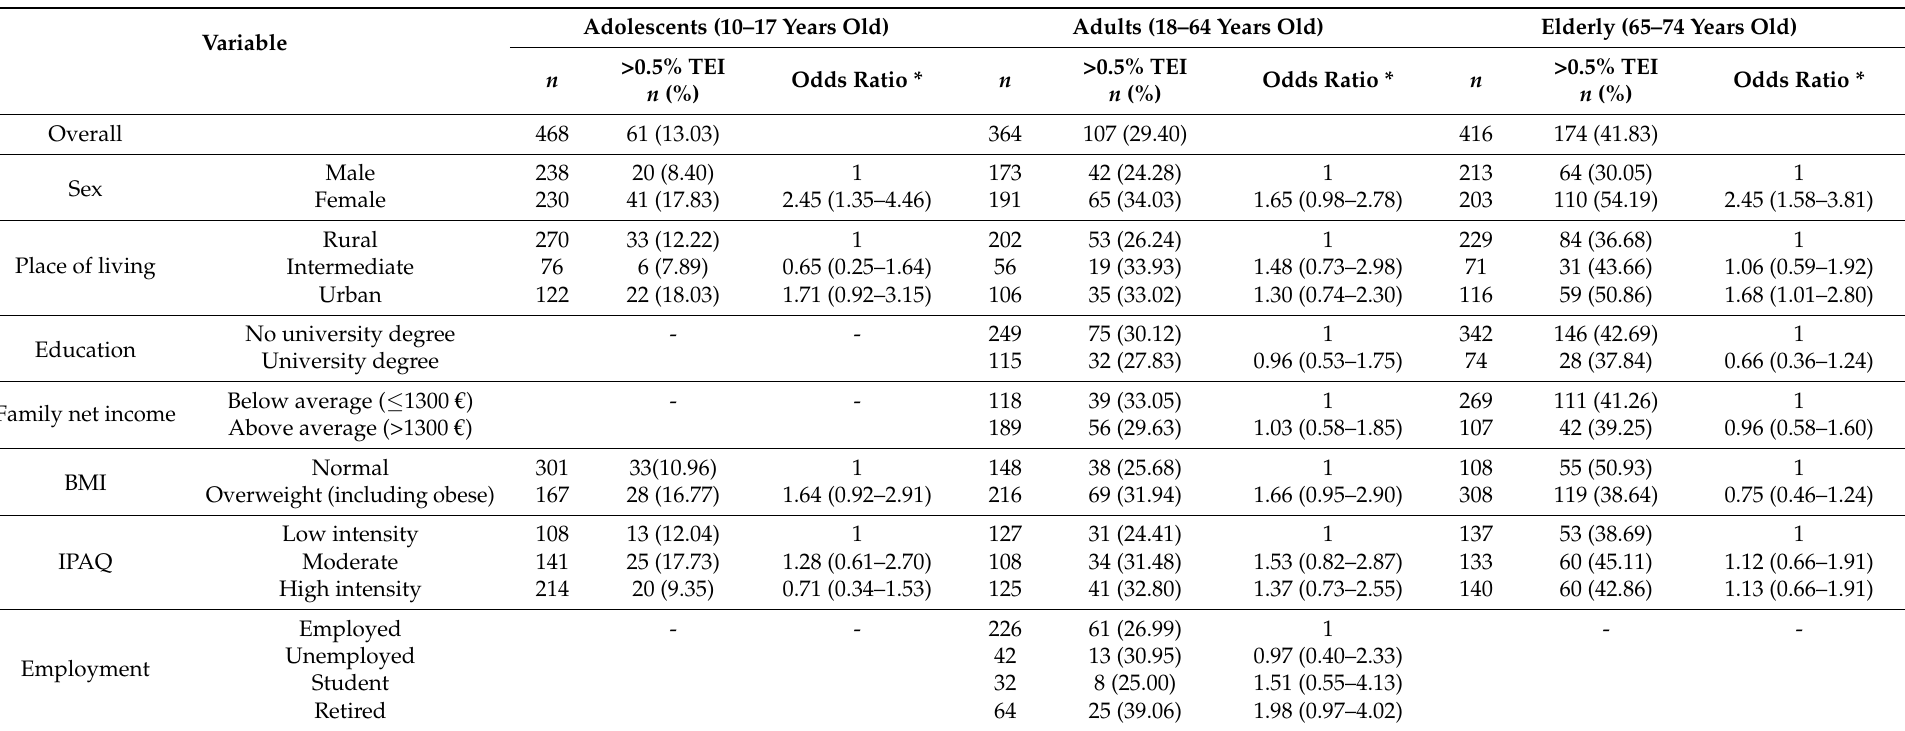
Table 3. Percentage of the population exceeding 0.5% of total energy intake (TEI) from trans fatty acid (TFA) intake by sex, place of living, education, family net income, body mass index (BMI), international physical activity questionnaire (IPAQ) score, and